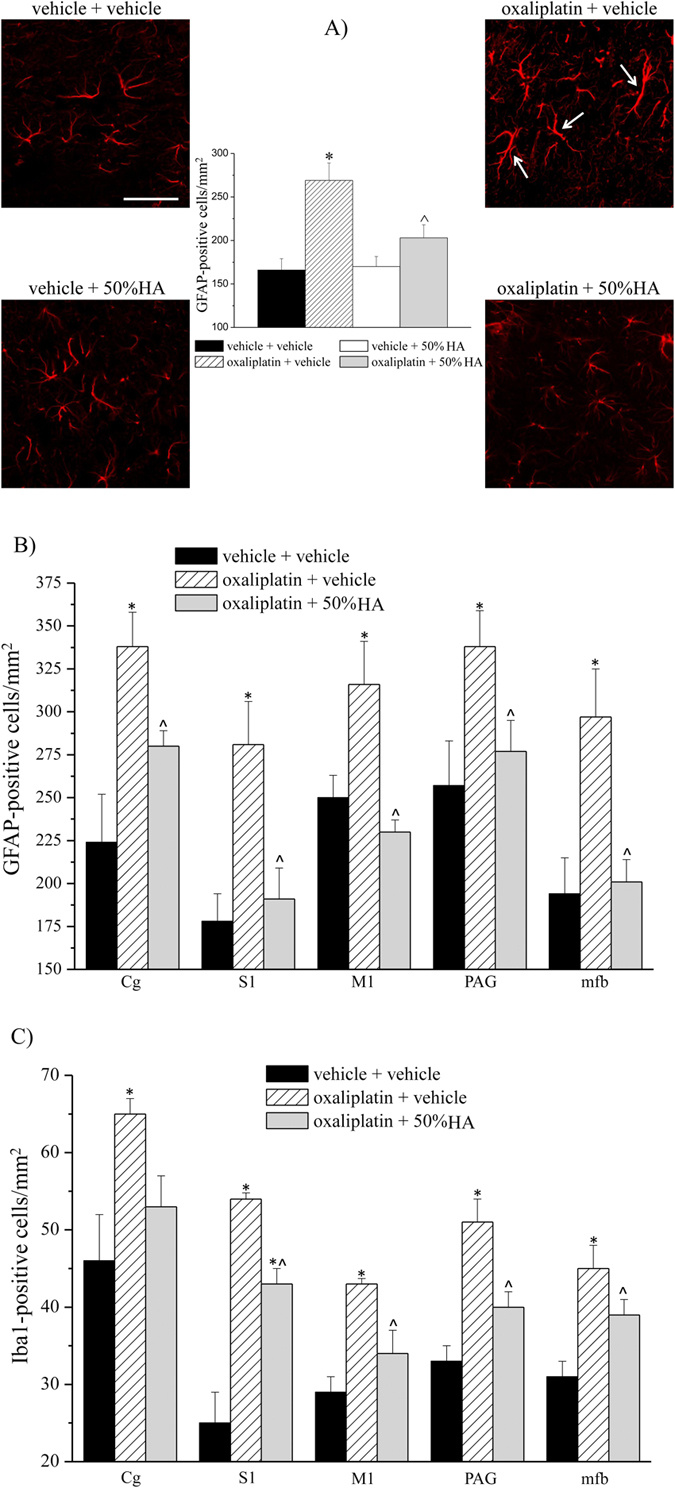
Effect of 50%HA on oxaliplatin-dependent astrogliosis in the central nervous system (A) Spinal cord. On day 21, the number of GFAP-positive cells was measured in the dorsal horn of the spinal cord. Representative immunohistochemical staining is shown (scale bar = 10 μm and original magnification 20X, for all images) and black arrows evidenced that the activate astrocytic morphology induced by oxaliplatin administration (oxaliplatin + vehicle) is completely reverted by 50%HA presence. (B) and (C) Brain areas. The number of (B) GFAP- and (C) Iba-1-positive cells was evaluated in oxaliplatin-treated rats on day 21 analyzing the following areas: Cg1, cyngulate cortex area 1; S1, primary somatosensory cortex; M1, primary motor cortex; PAG, periaqueductal grey; mfb, medial forebrain bundle. Each value represents the mean ± SEM of 6 rats per group, performed in two different experimental sets. *P < 0.05 versus vehicle + vehicle; ^P < 0.05 versus oxaliplatin + vehicle.